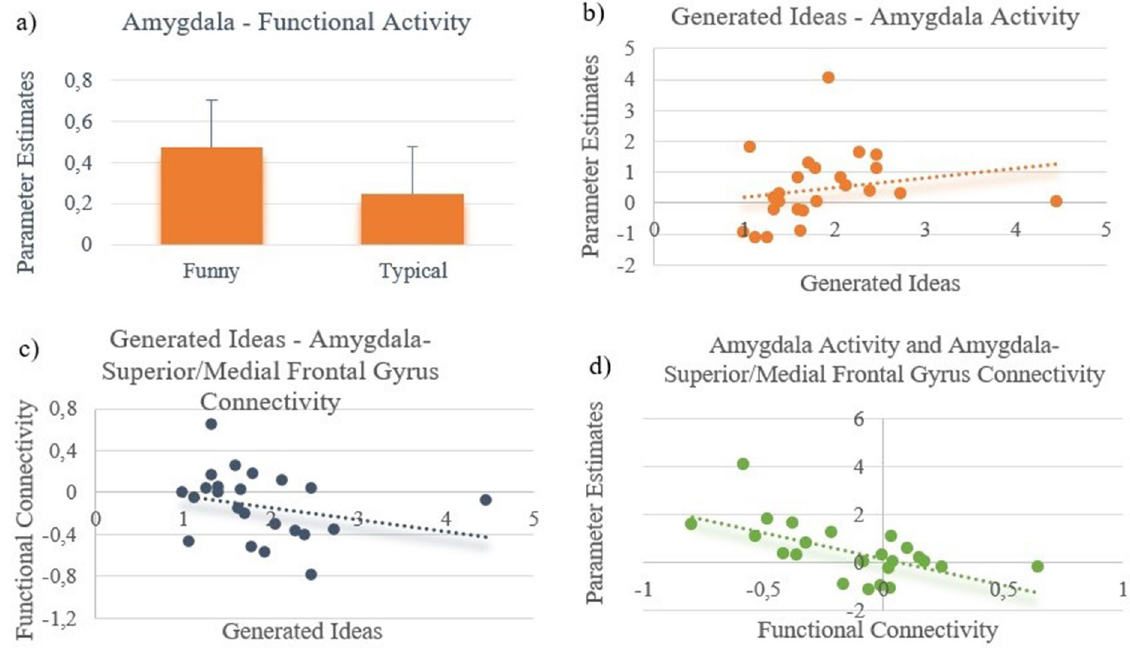
Figure 4. ( a ) Significant higher functional activity in the amygdala in the funny vs. typical condition, the error bars represent SEM. ( b ) Higher amygdala activity was associated with increased generation of funny idea. ( c ) Reduced functional connectivity between the amygdala and the superior/medial frontal gyrus was associated with increased funny idea generation ( d ) A higher negative functional connectivity between the amygdala– superior/medial frontal gyrus was associated with an increased functional activity in the